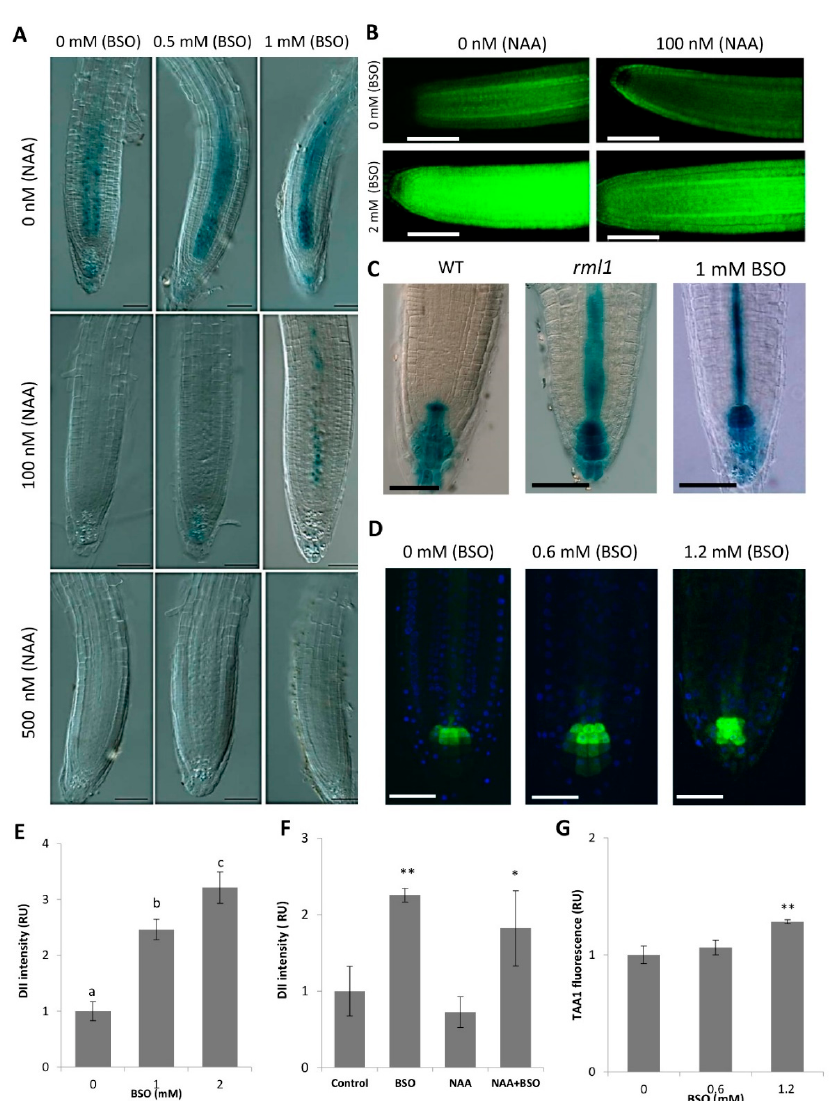
Figure 3. Effect of GSH level on auxin response markers and auxin biosynthesis gene expression. ( A ) BSO dose-dependently increases AXR3NT-GUS stability in response to auxin. Seven-day-old seedlings were treated for 12 h with different L-buthionine-(R,S)-sulfoximine (BSO) concentrations in the liquid medium and/or pre-treated in the control medium. Seedlings were subjected to heat shock by cultivation at 37 °C for 1.5 h, allowed to recover for the next 10 min, and then subjected to GUS assays for the next 1–1.5 h; ( B ) BSO increases DII::VENUS stability without and with NAA application; ( C ) DR5::GUS signal in wildtype seedlings, rml1 mutant seedlings, and seedlings treated with 1 mM BSO; ( D ) TAA1::GFP signal in RAM upon BSO treatment. Scale bar − 50 µm. ( E ) DII::VENUS quantification in response to BSO concentrations. Error bars represent the means ± SDs (n = 6). Different letters indicate a significant difference at p < 0.05; ( F ) DII::VENUS quantification following BSO and NAA treatments (represented image in B). Error bars represent the means ± SEs (n = 6); ( G ) TAA1::GFP quantification in RAM (represented image from D). Error bars represent the means ± SDs (n = 8). Means of treatments with * and ** are significantly different from means of the control at p < 0.05 and p < 0.01, respectively. Fisher’s protected LSD test was used to compare the individual means.